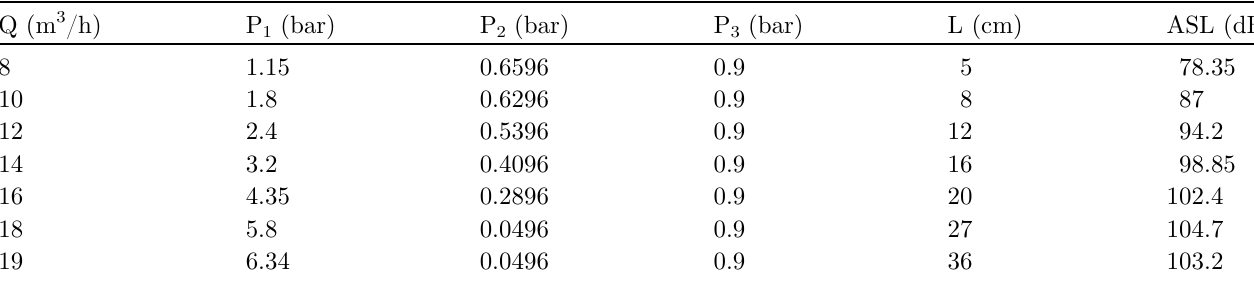
Table 1. The experimental results for the ori fi ce with the 0.3 contraction ratio.